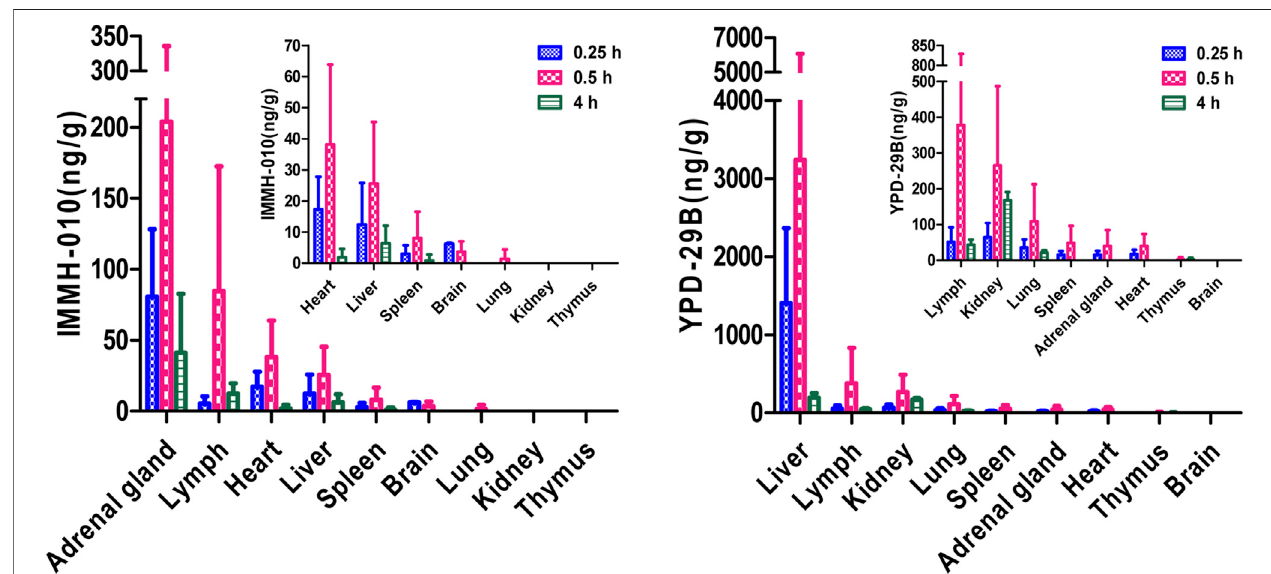
FIGURE 5 | Tissue distribution of IMMH-010 and YPD-29 B in rats after a single i. g. administration of IMMH-010 maleate at 10 mg/kg ( n (cid:1) 5).